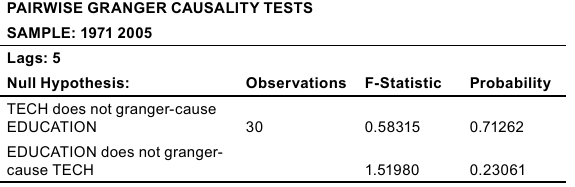
table 6 Causality test between education expenditure and technological